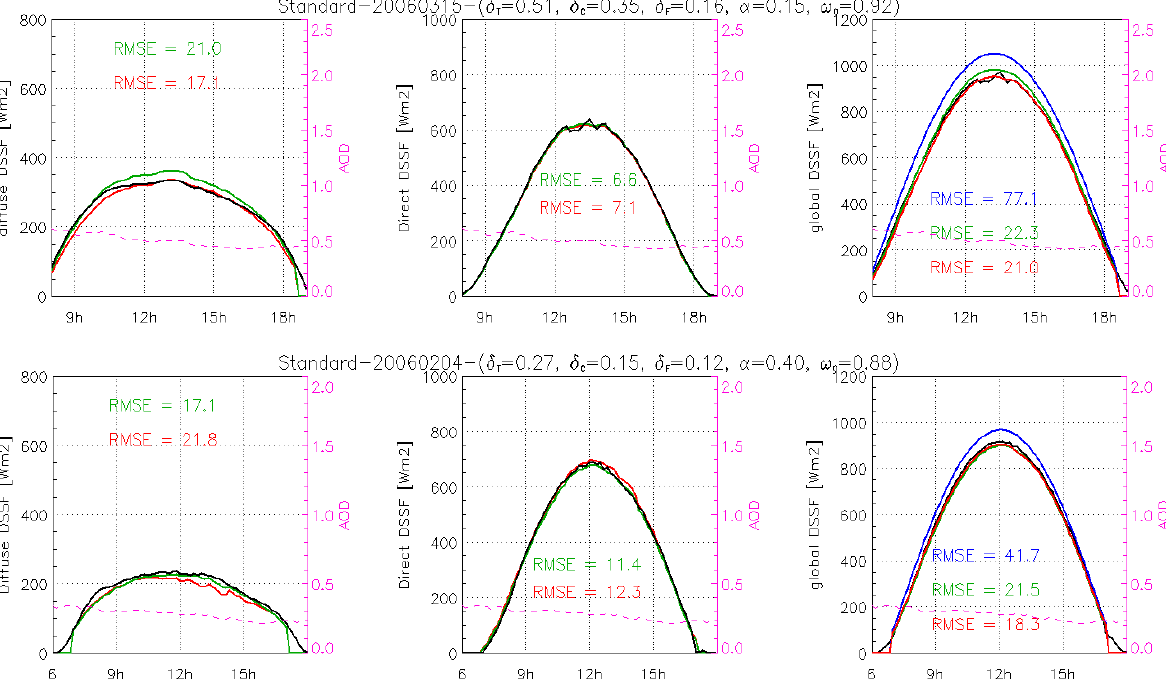
Figure 6. Same as Figure 5 for standard days in Dakar (15 March) and Niamey (4